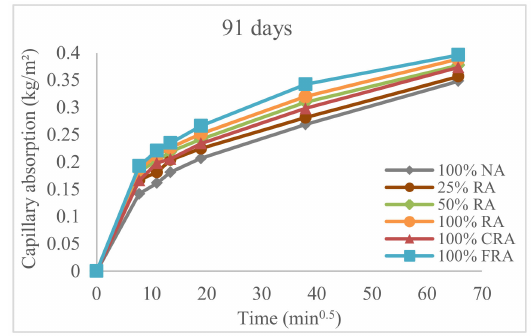
Figure 4. Capillary water absorption results at 28 days.